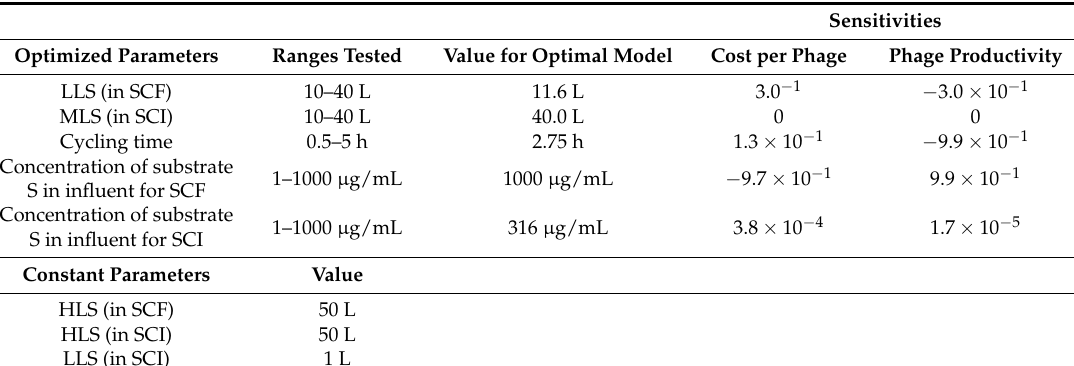
Table 1. Operational model parameters employed for the